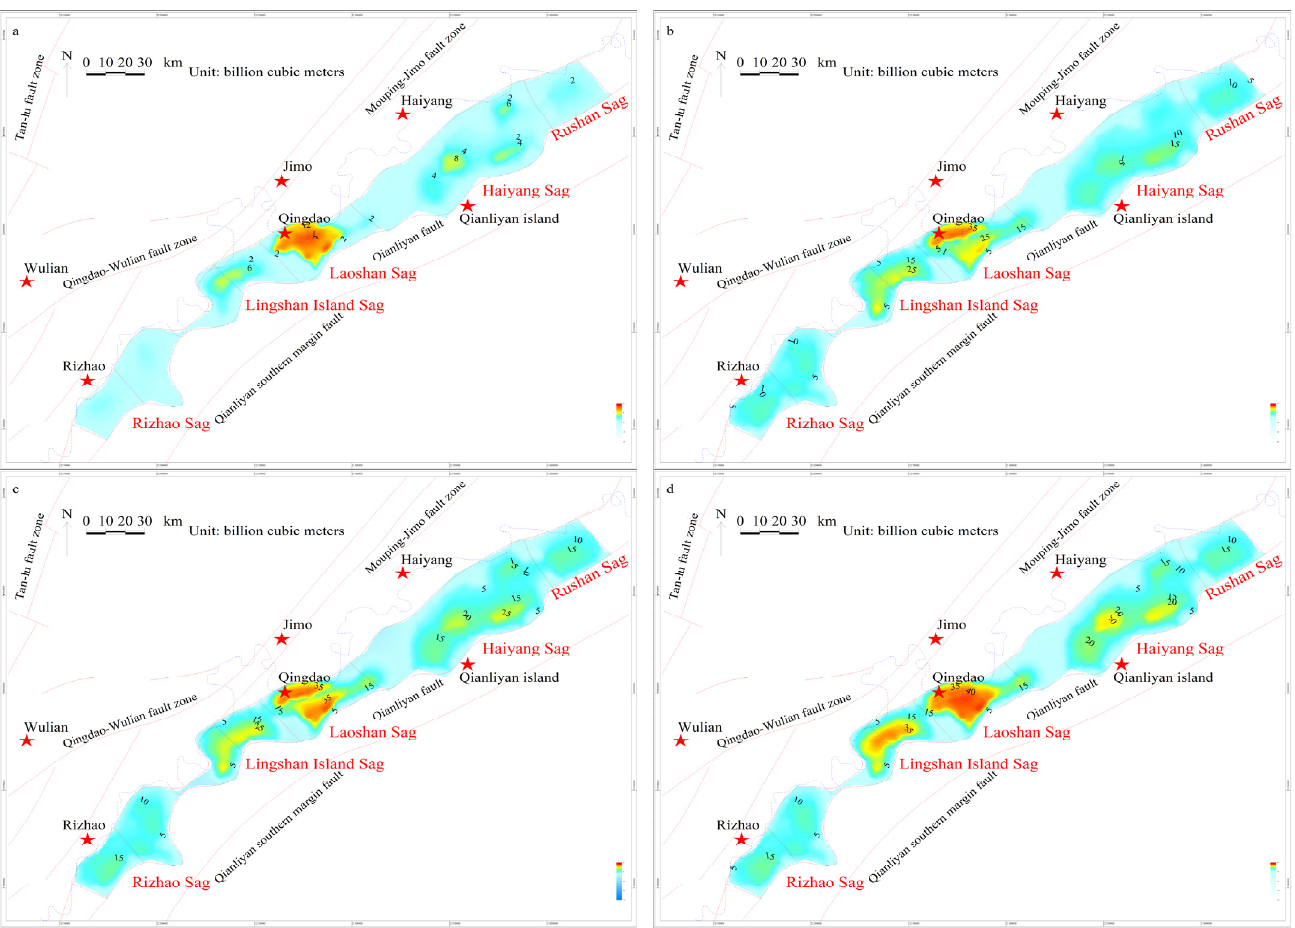
Figure 12. Gas generation volume of Ri-Qing-Wei Basin in different periods (( a ) gas volume at the end of Laiyang period; ( b ) gas volume at the end of Qingshan period; ( c ) gas volume at the end of Wangshi period; ( d ) current gas volume).